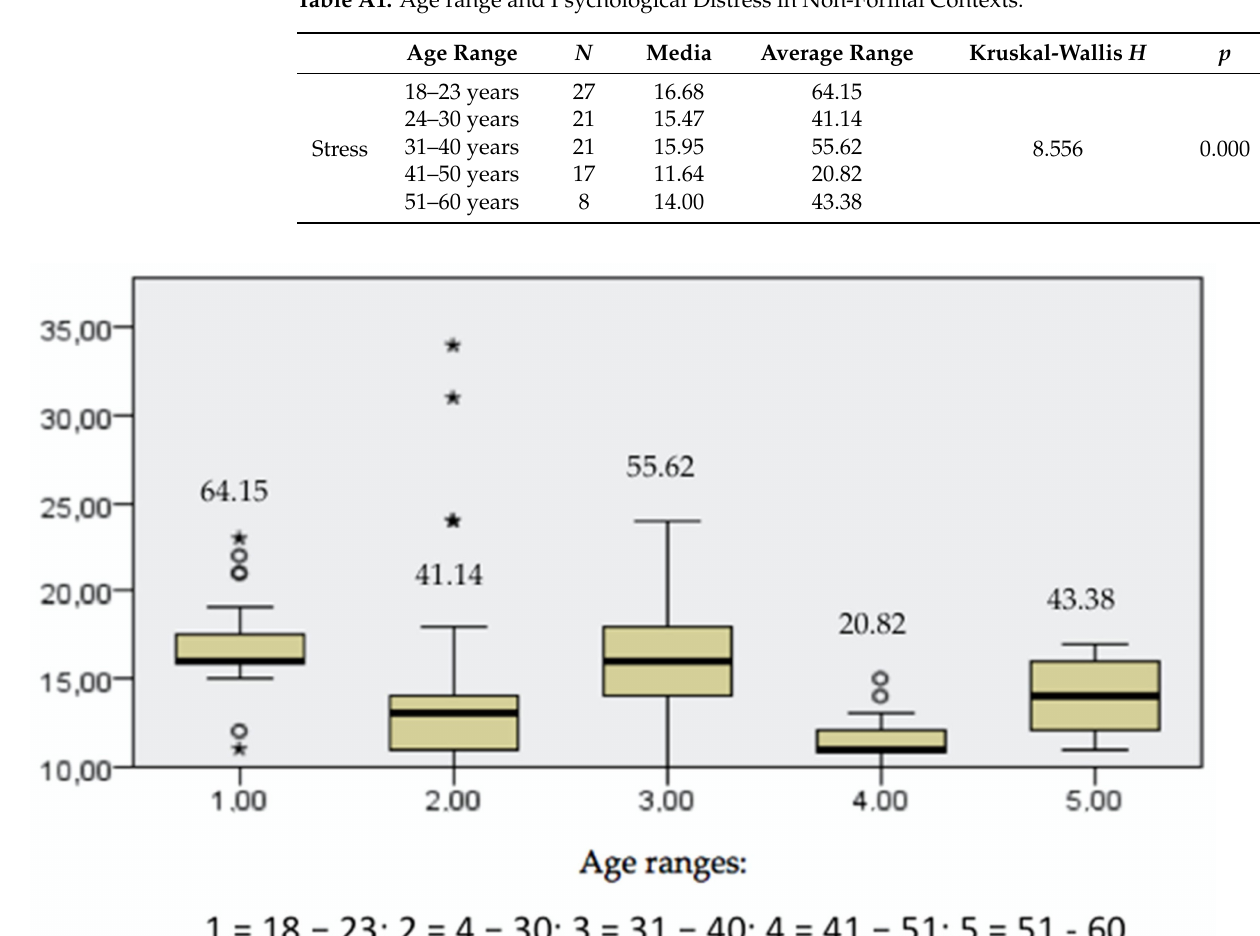
Table A1. Age range and Psychological Distress in Non-Formal Contexts.